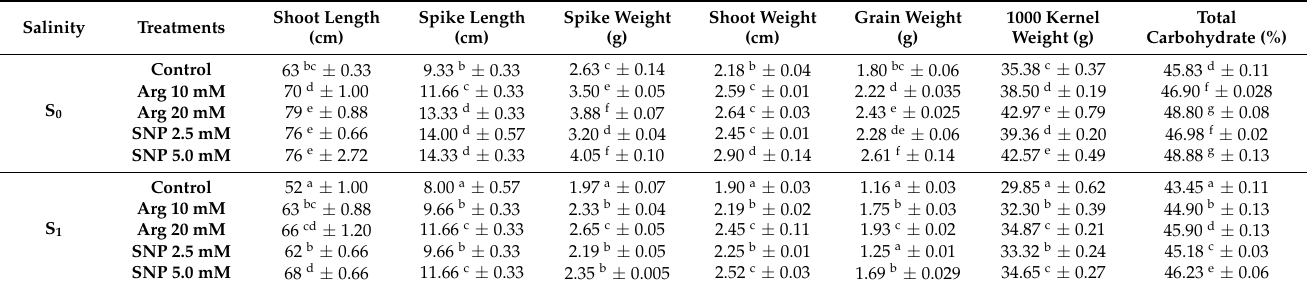
Table 4. Effect of arginine or SNP on yield, its components, and total carbohydrate% of wheat plant grown under salinity stress. S 0 = 1.2 mM NaCl, S 1 = 85.5 mM